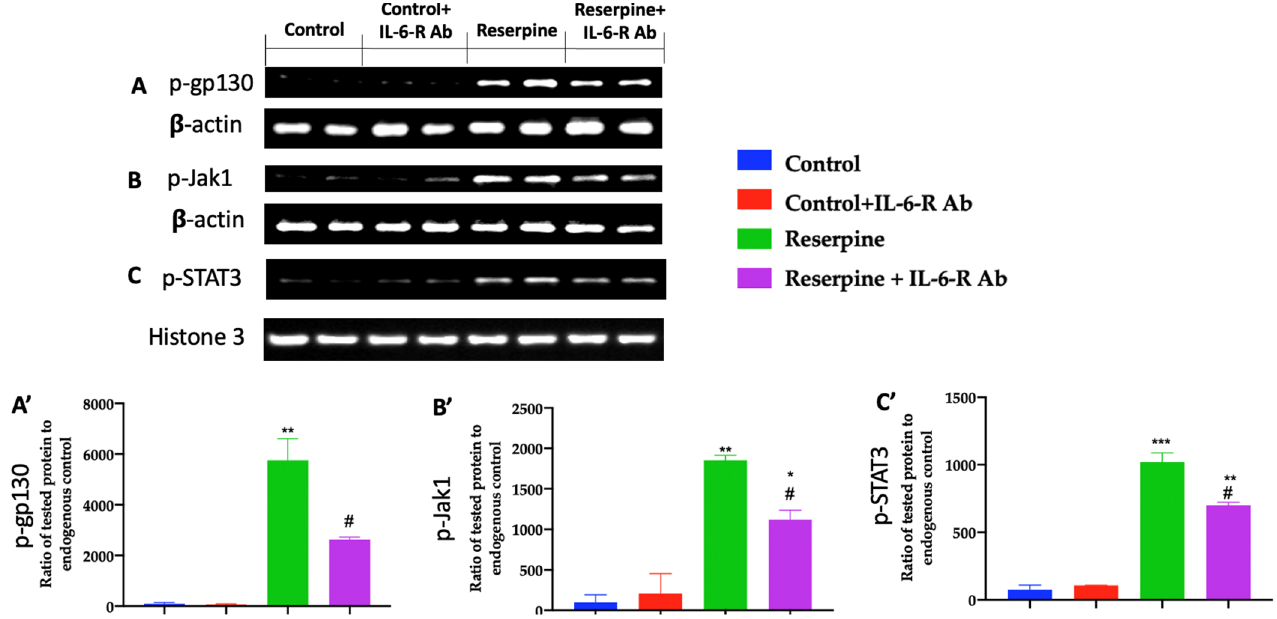
8 of 16 Figure 4. Effects of IL-6-R Ab on pro-inflammatory mediators: ELISA analysis of: ( A ) TNF- α , ( B ) IL- 1 β and ( C ) IL-6 expressions; RT-PCR analysis of: ( D ) Cxcl5, ( E ) Cxcl10 and ( F ) Cx3cl1 expression. 3.5. Analysis of the Jak/Stat Pathway